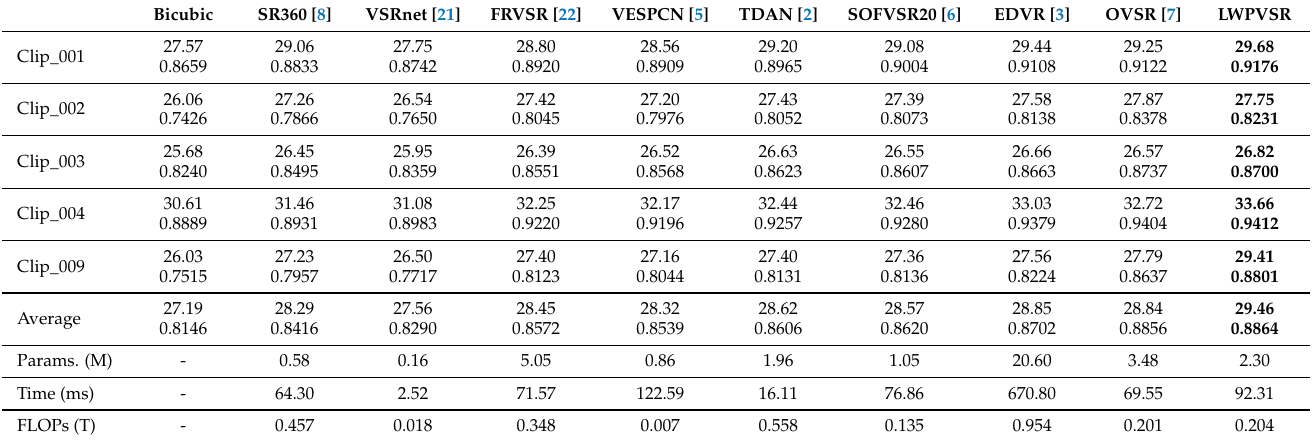
Table 3. Comparison of all the methods in terms of PSNR (top) and SSIM (bottom) on other video clips.